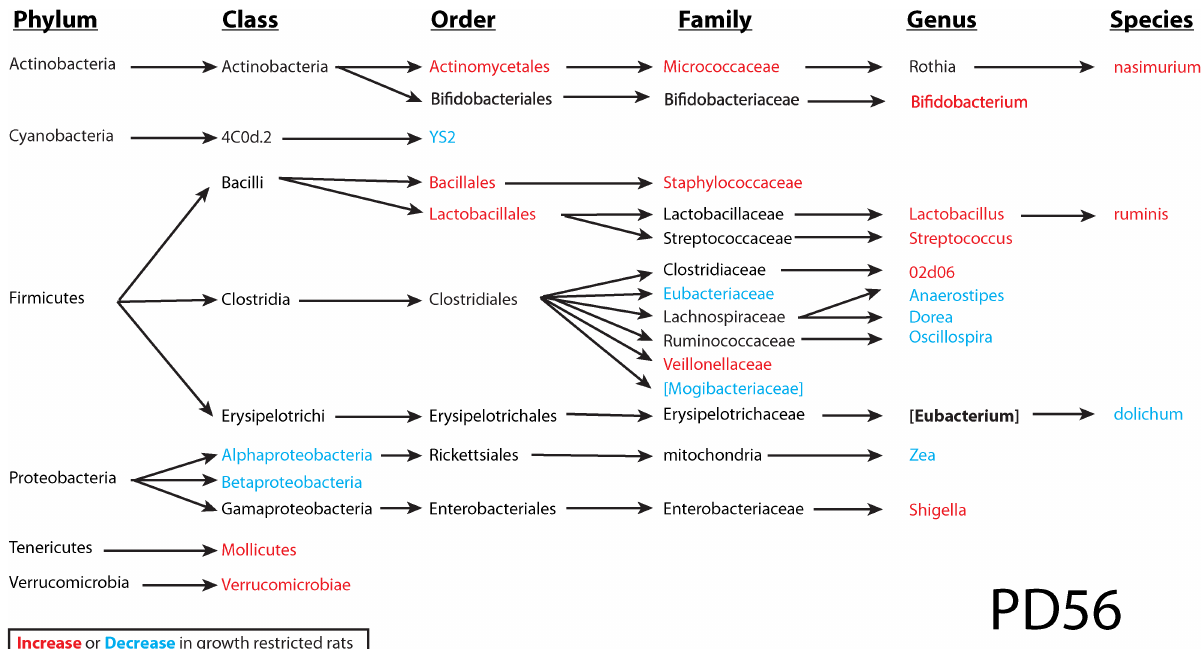
Fig 8. Colon microbial taxa at PD56. Significantlyaltered colon microbialtaxa by diet at PD56. In red are taxa that increase,and blue are taxa that decreasein growth-restricted rats. The significancewas determinedusing two-way ANOVA (iron treatment X diet) based on relative abundance data. The significancecut-off is p < 0.05. Disclaimer: in this small-scalepilot study (n = 4–6), multiple comparisons were not adjusted,and therefore results may contain false discoveries. Future confirmation is needed.